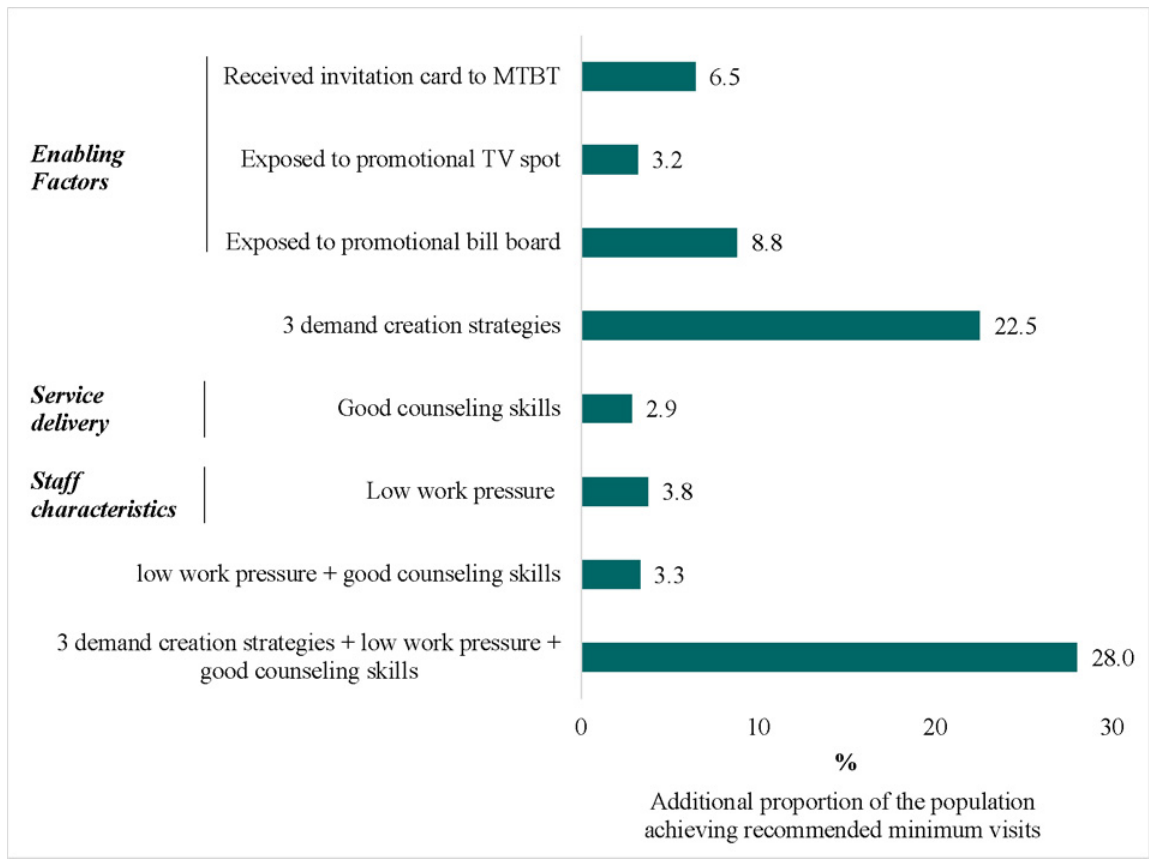
Fig 4. Population attributable risk of achieving the recommended minimum number of visits for select modifiable factors.